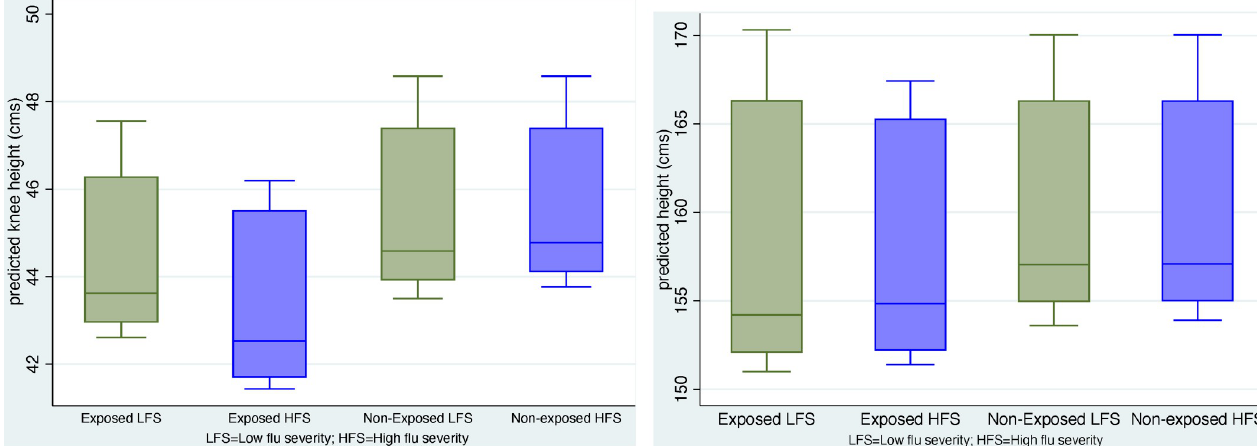
Fig 2. A. Box plots of predicted values of knee height. (Models including flu severity-full sample). B. Box plots of predicted values of height. (Models including flu severity-full